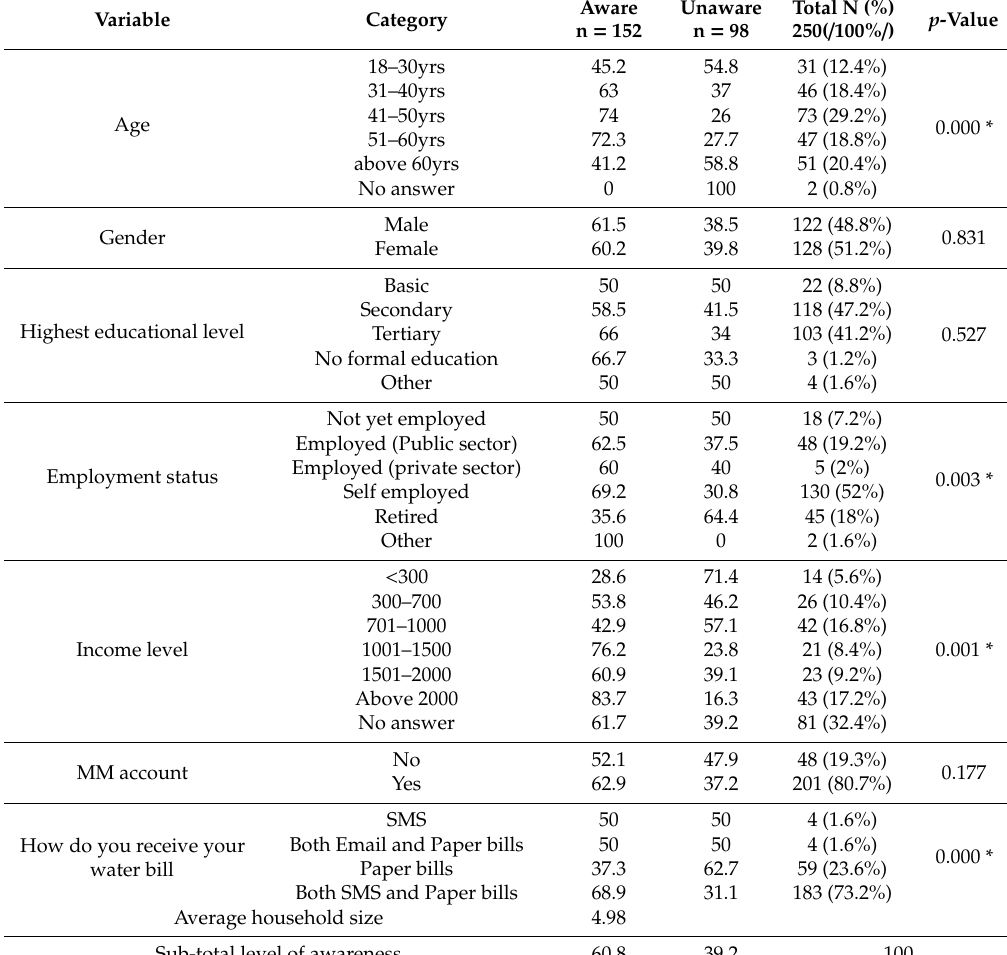
Table 2. Percentage / count distribution for selected dependent and independent variables by electronic water payment (EWP)